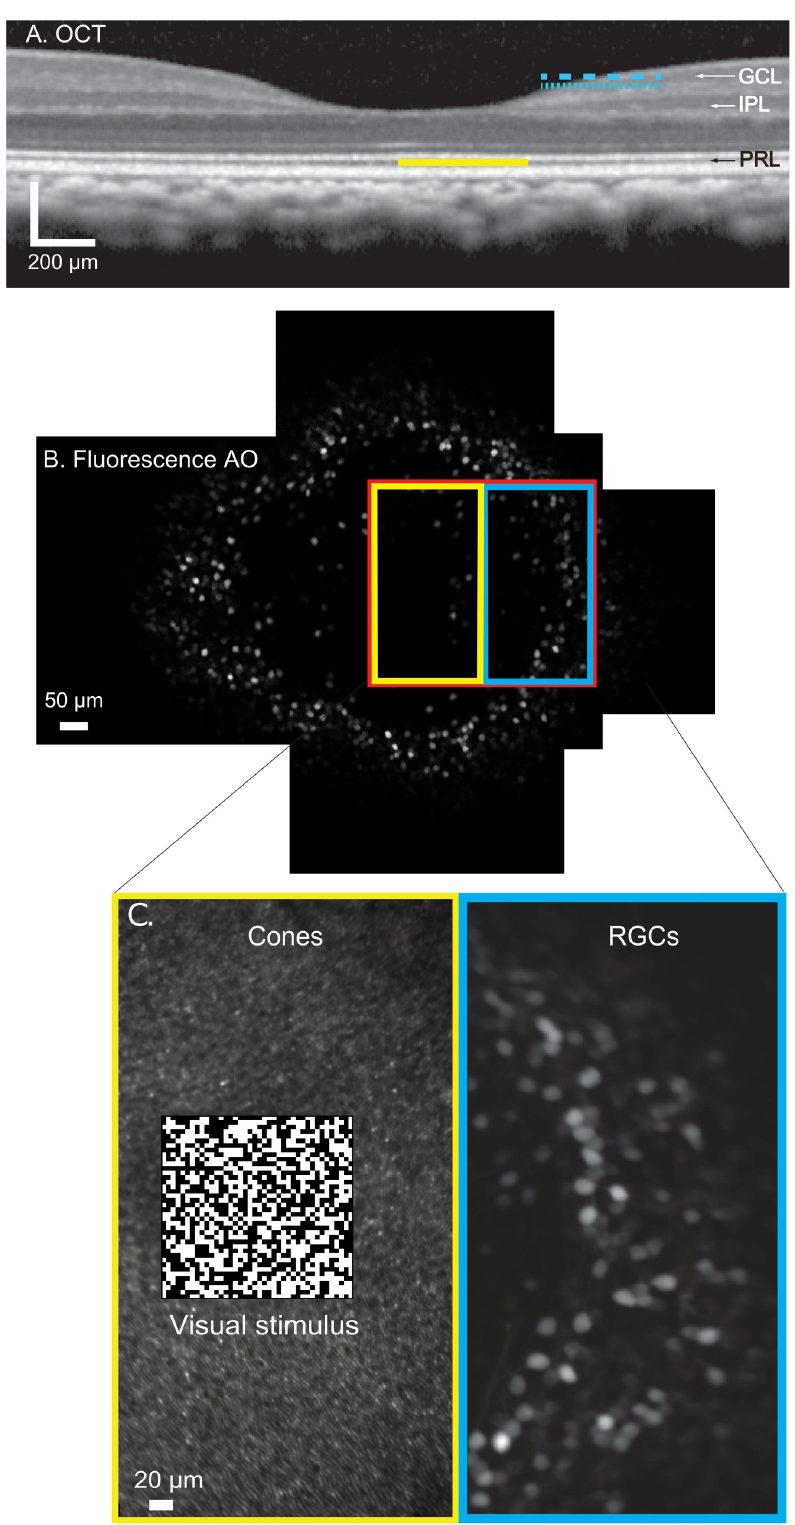
Fig 1. Illustration of the method. a) Optical coherence tomography (OCT) of the fovea of the imaged monkey. The response of G-CaMP6s expressing retinal ganglion cells, located in the ganglion cell layer (GCL), were recorded with